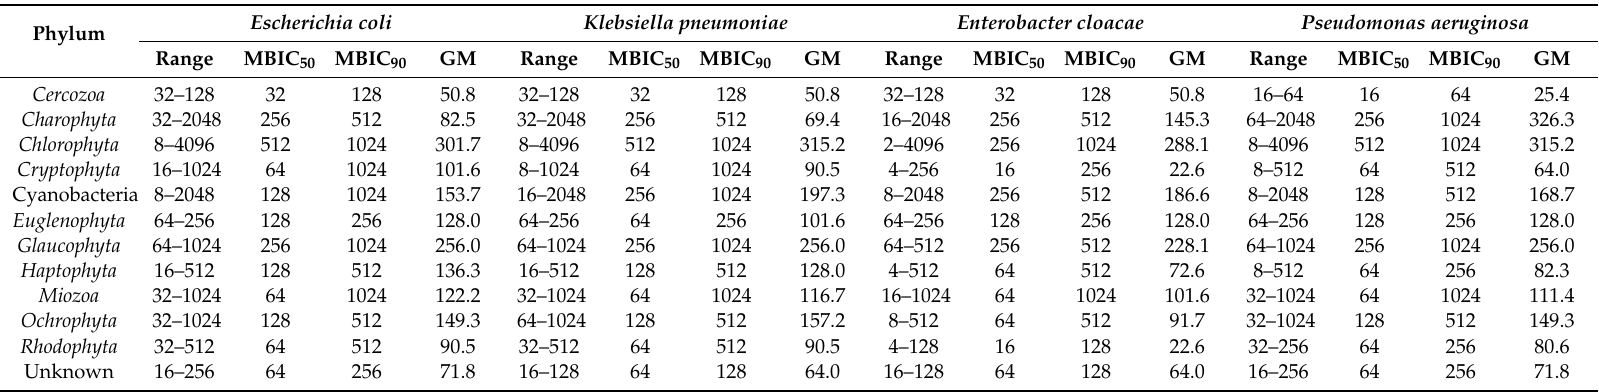
Table 1. Antibiofilm activity against Gram-negative bacteria of marine natural products. Range: range of concentrations tested; MBIC 50 : lowest concentration of the test compound that resulted in ≥ 50% inhibition of biofilm formation; MBIC 90 : lowest concentration of the test compound that resulted in ≥ 90% inhibition of biofilm formation; GM: geometric mean. MBICs are reported in µ g / mL.